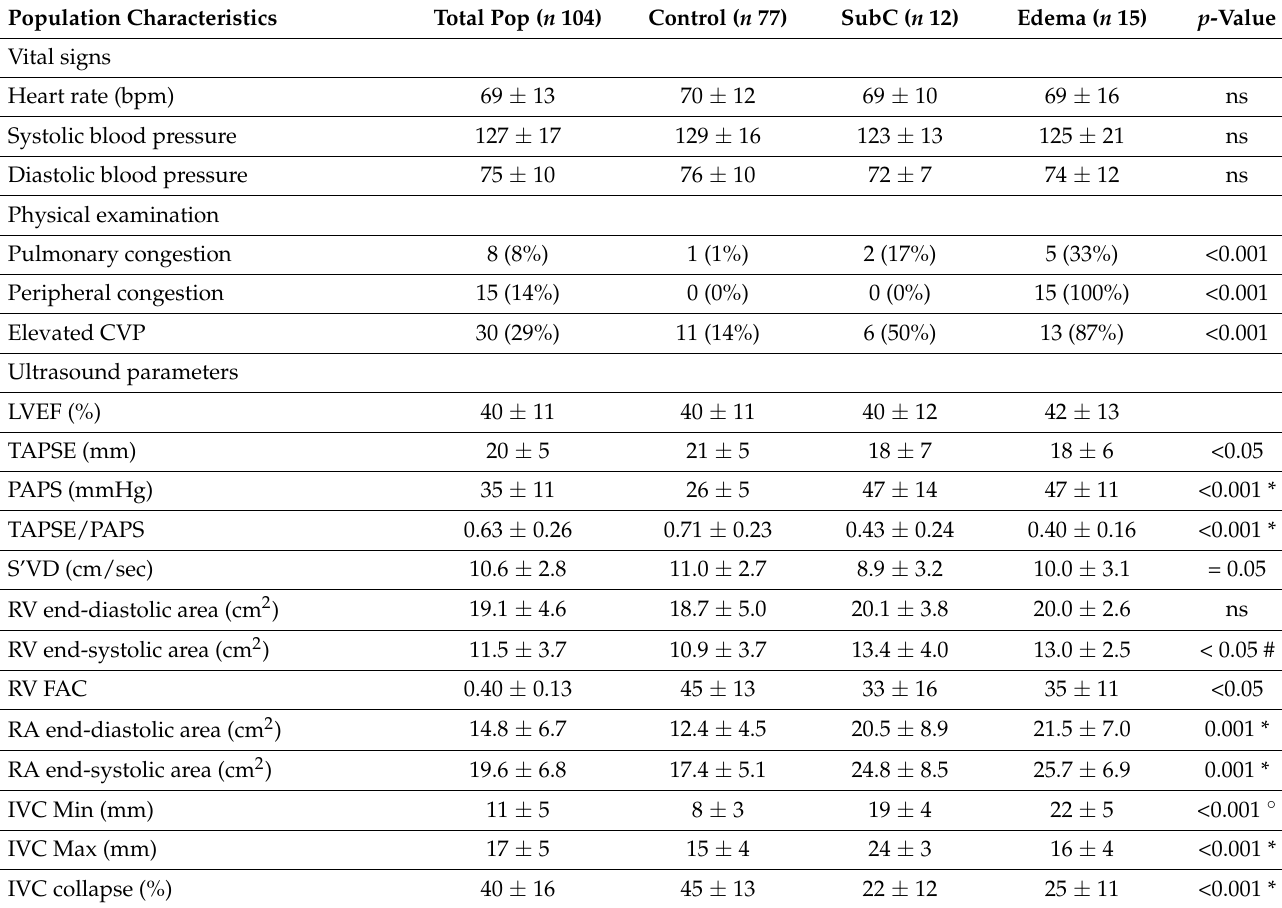
Table 3. Main PE and echographic characteristics divided into subgroups under comparison. Group “Control”: patients without clinical signs of peripheral congestion nor echographic signs of congestion. Group “SubC” (Sub Clinical congestion): patients with echographic signs of congestion without peripheral clinical congestion. Group “Edema”: patients with peripheral congestion irrespective of echographic